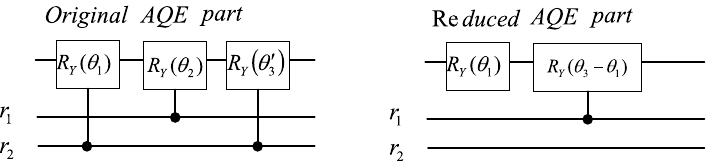
Figure 3. The quantum circuits before and after the improvement of the AQE stage in the hybrid HHL